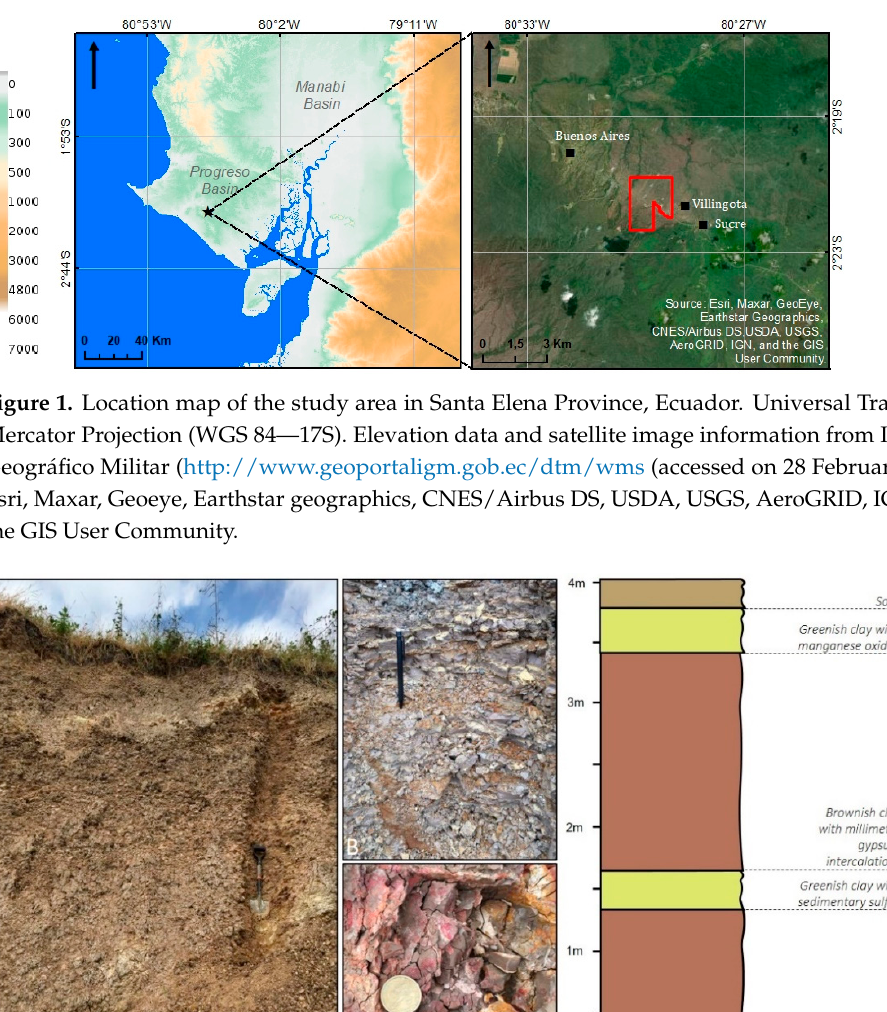
Figure 2. Outcrop ( A – C ) and geological column of the natural clays, iron, and manganese oxides that can be observed in some areas of the study area, the Dos Bocas formation, Santa Elena province, Ecuador.